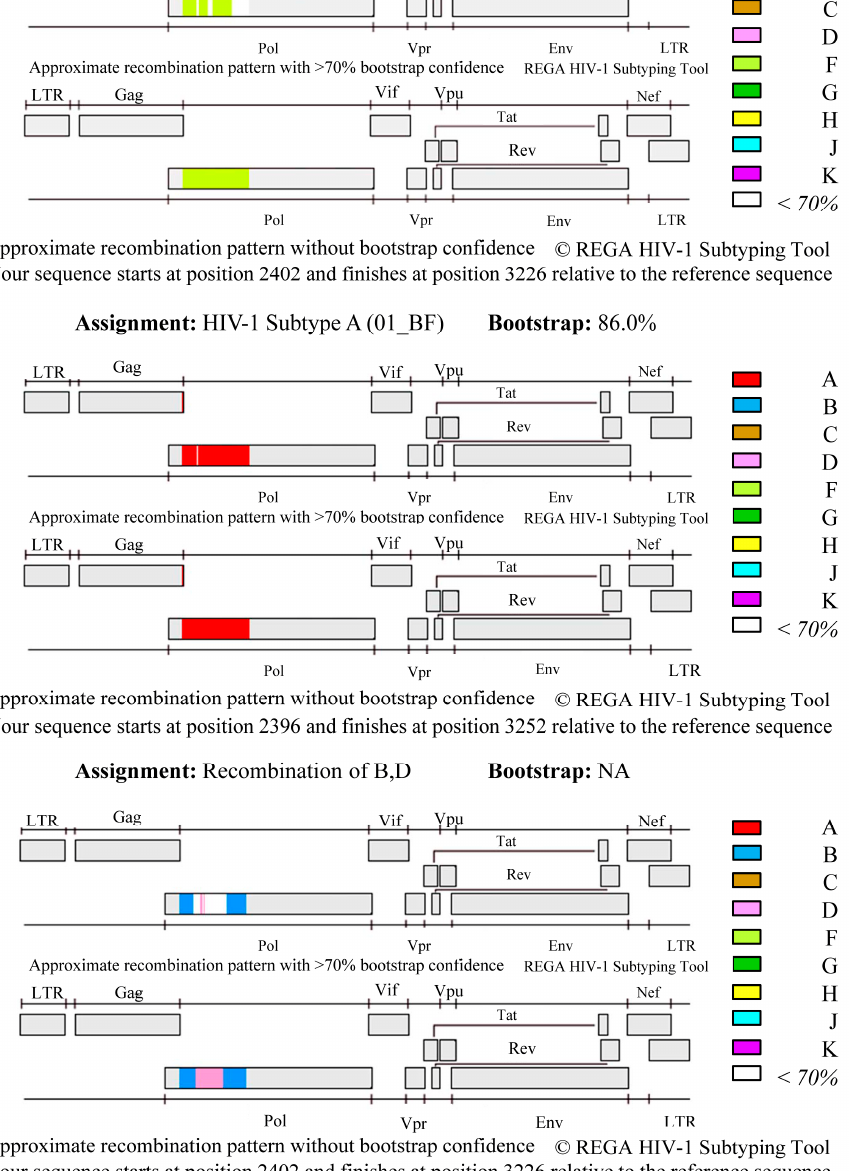
Figure 4. Cont. Figure 4.